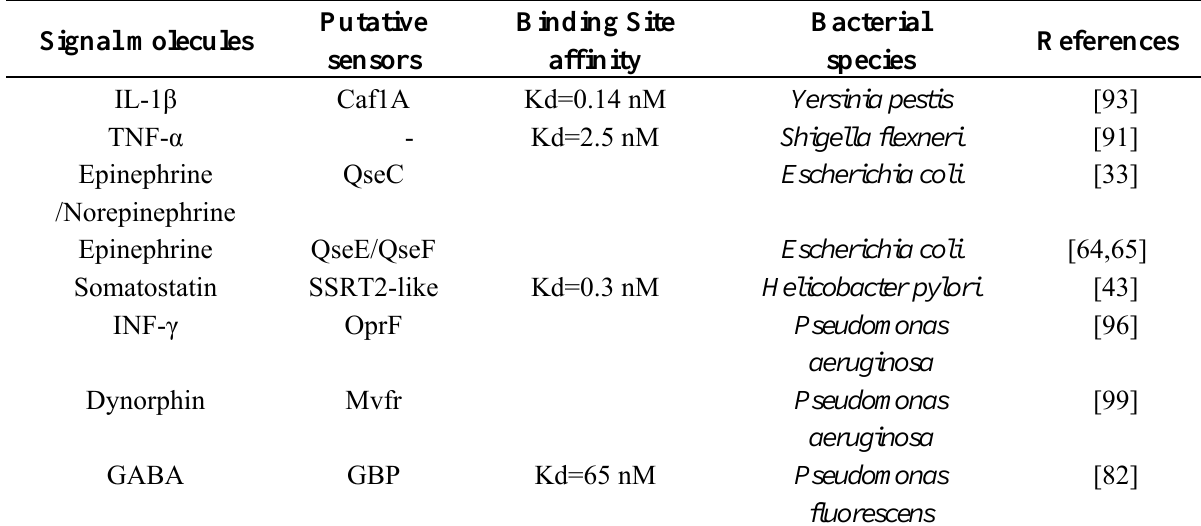
Table 4. Bacterial sensors for eukaryotic signal